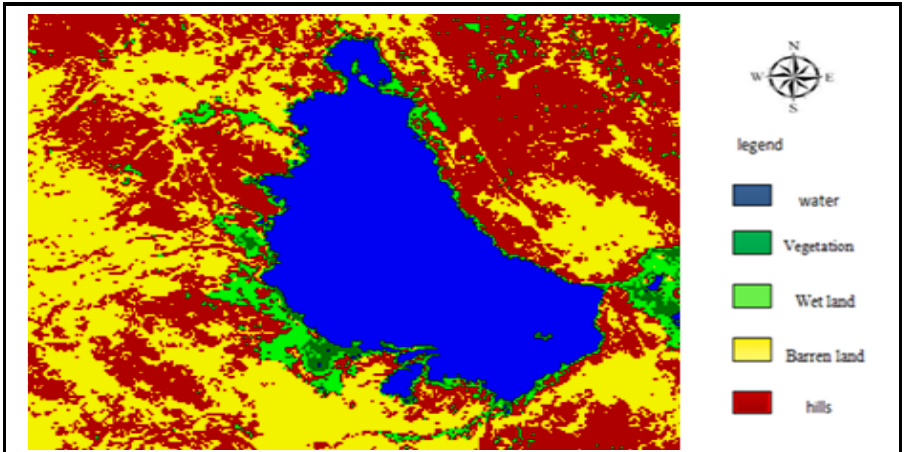
Fig.4: Unsupervised classification using mean value for Landsat-5 (1990).